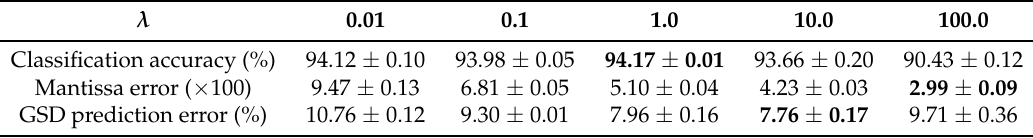
Table 6. GSD prediction performance for the different values of weight λ with the log GSD scale dataset 1.